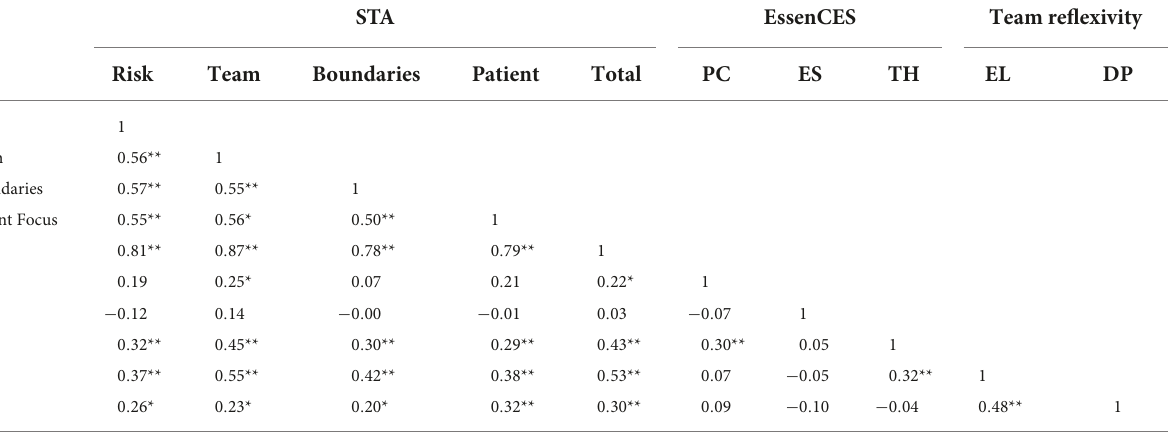
TABLE 3 Pearson’s correlation coefficients between study